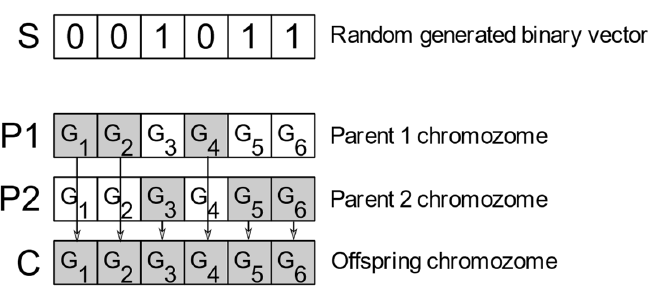
Figure 4. Genetic algorithm: crossover operator.